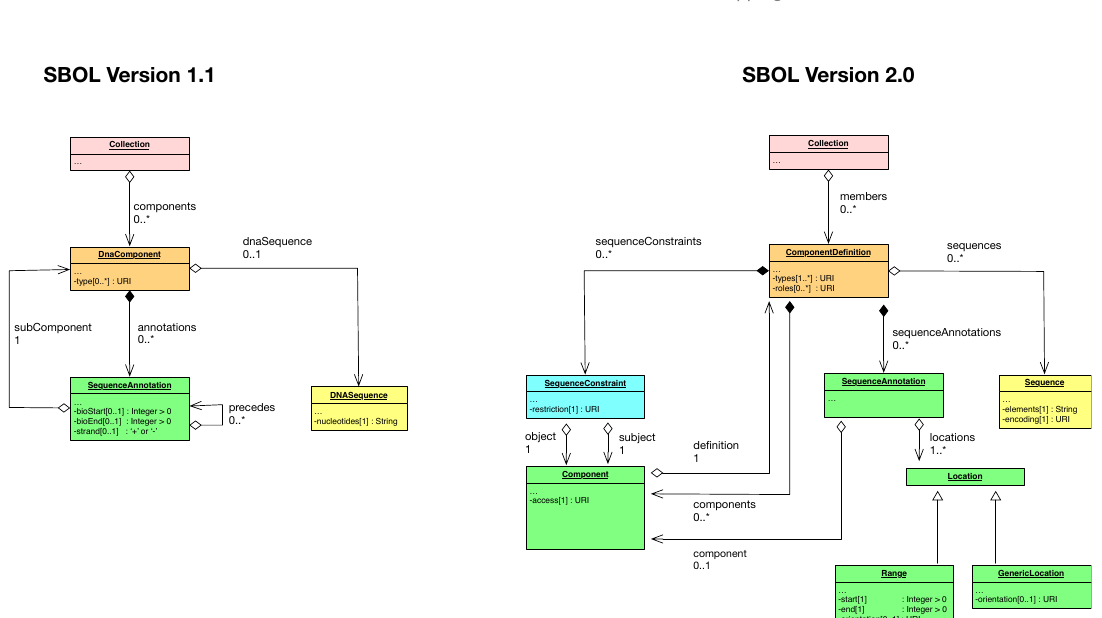
Figure 25: The mapping from the SBOL 1.1 data model to the SBOL 2.x data model, indicating corresponding classes/properties by